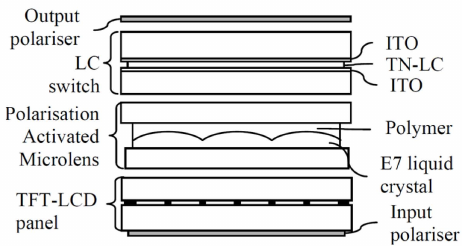
Figure 9. Polarization activated microlenses [22]. Reprinted with permission from De Boer, D.K.G.; Hiddink, M.G.H.; Sluijter, M.; Willemsen, O.H.; de Zwart, S.T. International Society for Optics and Photonics; published by SPIE,